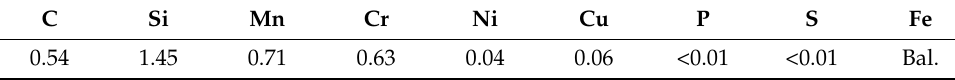
Table 1. Chemical composition (wt.-%) of the investigated